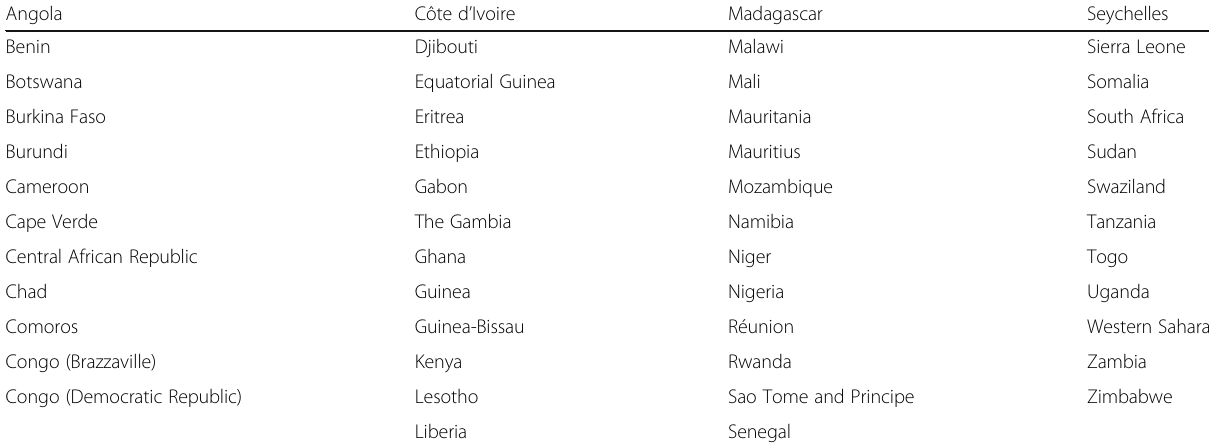
Table 2 ‘ Sub Saharan African (SSA) countries